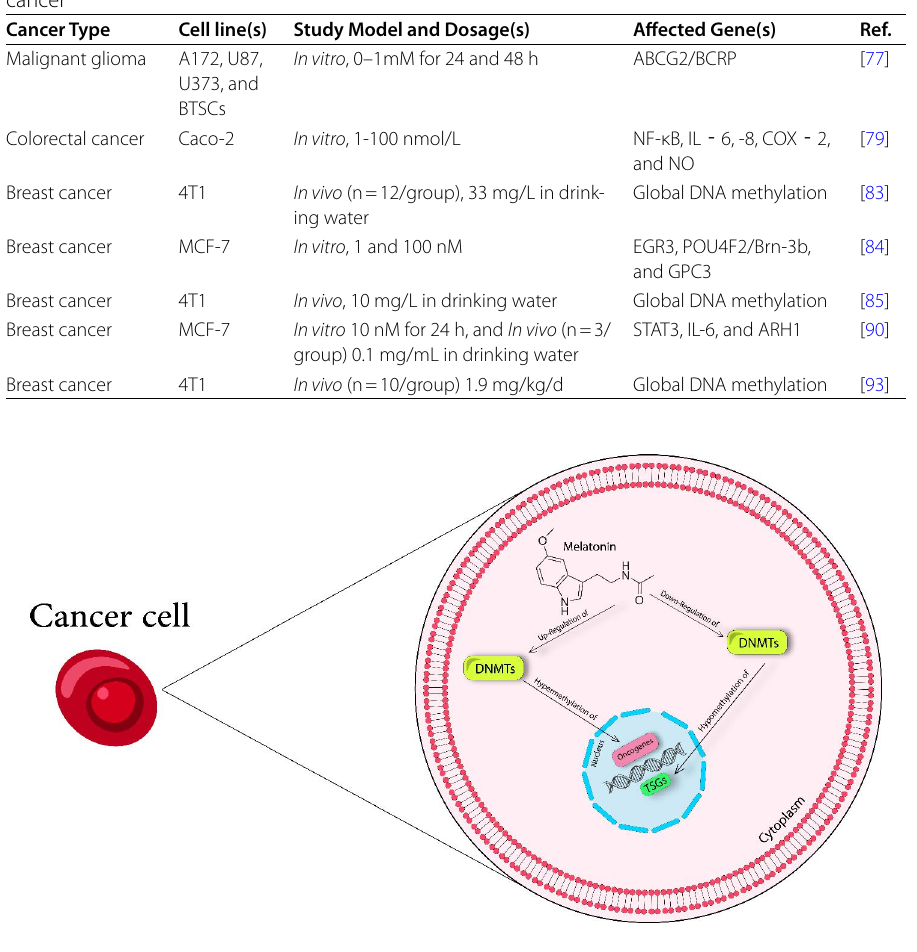
Fig. 1 Melatonin and cancer suppression: Insights into its effects on DNA